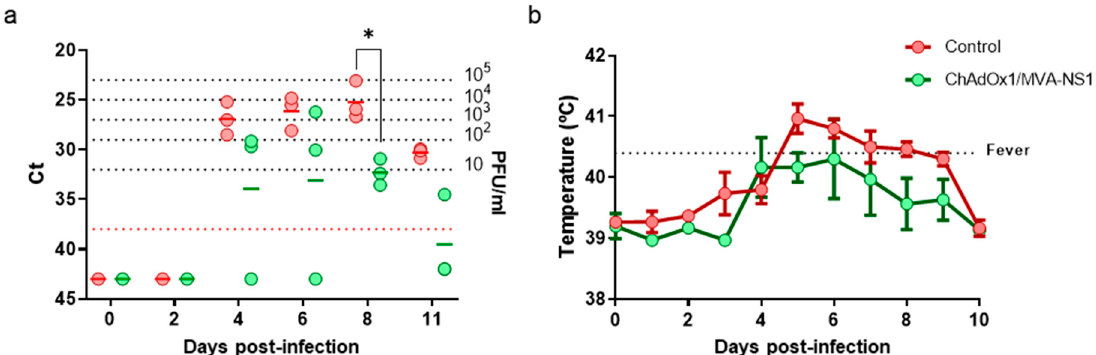
Figure 8. Analysis of protection elicited by ChAdOx1/MVA-NS1 immunization in sheep after infection with BTV-4M. ( a ) Viremia analyzed by RT-qPCR. Expression of mRNA of segment 5 (encoding NS1 protein) was quantified at 0, 2, 4, 6, 8 and 11 d.p.i. with BTV-4M. Results are expressed as Ct (left y -axis) and PFU equivalents (right y -axis and dotted horizontal lines). Cut-off Ct ≥ 38 (dotted pink line). Differences between groups were calculated by multiple t test analysis sing the Sidak–Bonferroni method. * p -value < 0.033 ( b ) Mean rectal temperatures responses in ChAdOx1/MVA-NS1 vaccinated and non-vaccinated sheep from 0 to 10 d.p.i. with BTV-4M. The fever threshold (dotted black line) was set to ≥ 40.50 °C based on the mean plus three standard deviations of the rectal temperatures recorded in the six sheep for one week before challenge. Dots indicate media of the group. Error bars represent SEM. Differences between groups were calculated by multiple t test analysis using the Sidak–Bonferroni method.